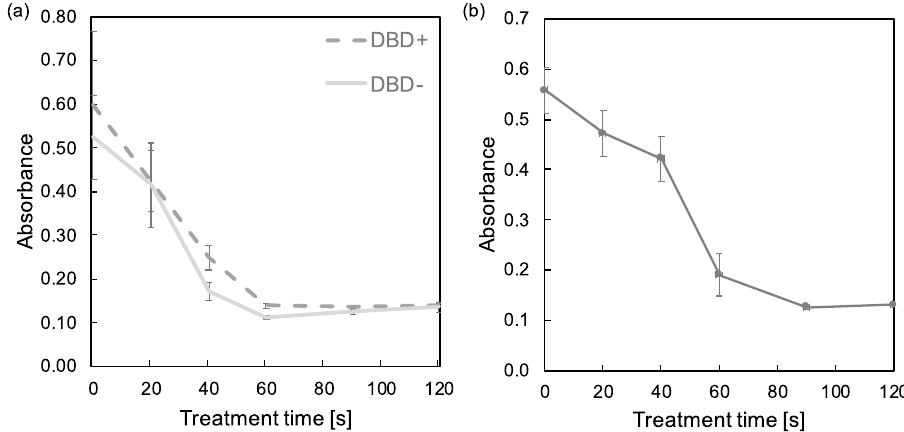
Figure 4. Absorbance of 570 nm spectrum 24 h after treatment. ( a ) Jurkat cell, ( b ) U937 Cell treated by − ns-DBD . Results from 40 s onward achieved a p < 0.05 (n =